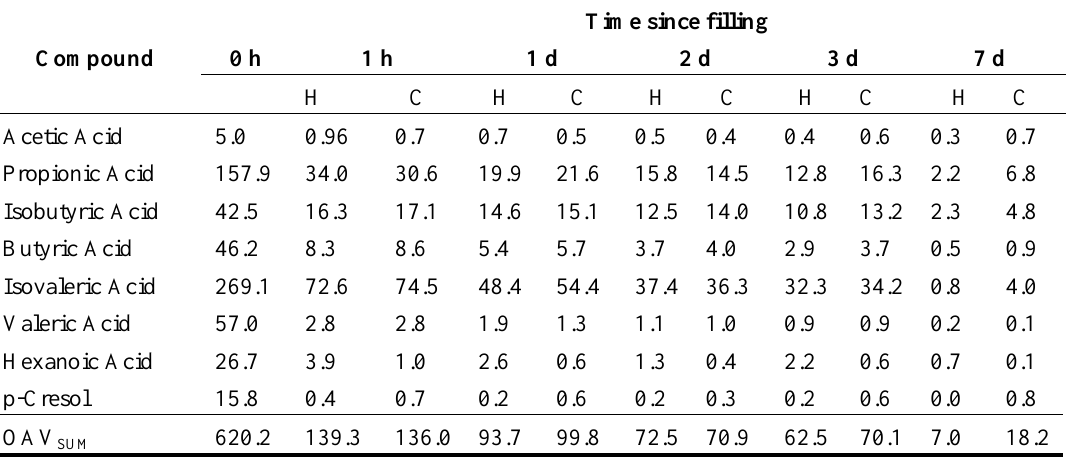
Table 5. Odor activity values (OAVs) in Homemade (H) and Commercial (C) Tedlar PVF bags filled with the VOC standard gas mixture.